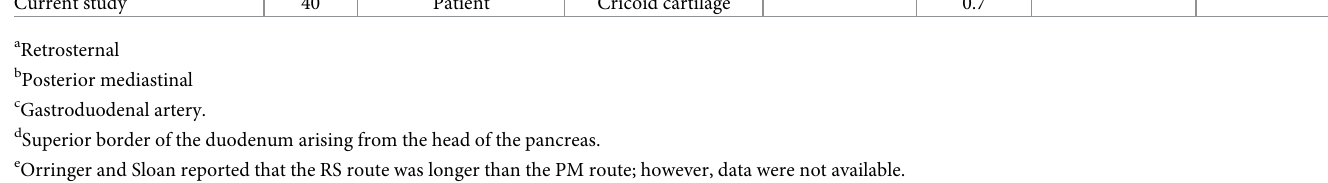
point was the lower border of the cricoid cartilage, similar to that reported in previous studies. In all cases, the level of the anastomosis was accurately determined via the CT images because a stapling device was used for cervical anastomosis. Additionally, the level of anastomosis in all cases was determined at the oral side rather than at the jugular notch. Although the proximal reference point for measurement was the lower border of the cricoid cartilage and not the level of anastomosis, the difference did not affect the measurement results. The distal reference points varied in each study, including the GDA, celiac axis, pyloric ring, and duodenum at the